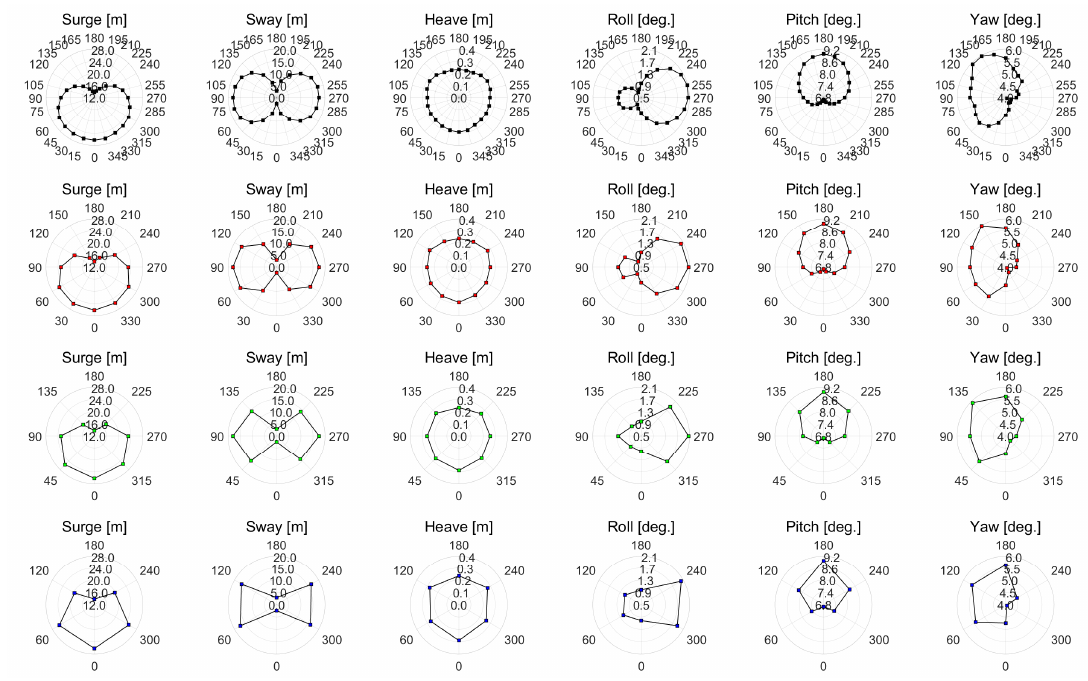
Figure 14. Maximum values of the platform’s motion according to the interval angles.